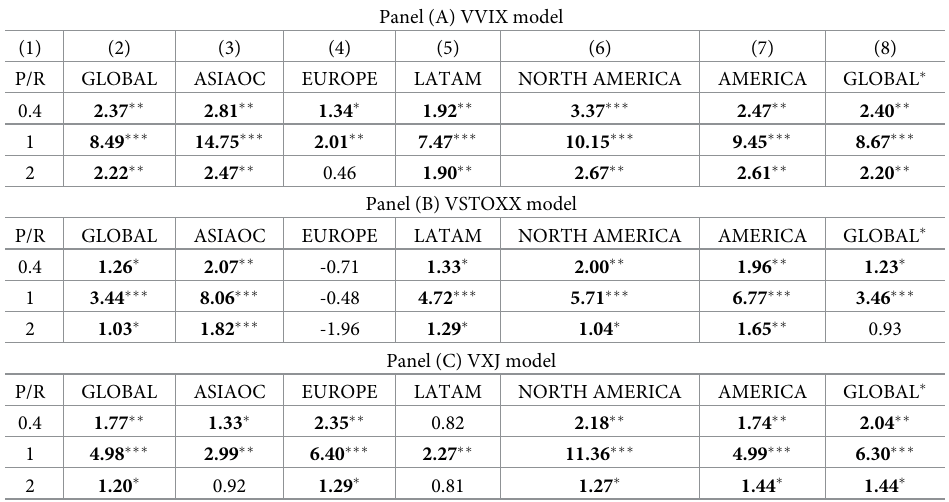
Table 6. Forecast variation in MSTL with volatilities